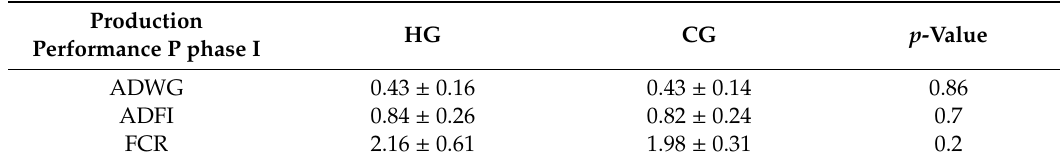
Table 4. E ff ect of gentle handling on production performance of pigs during phase I (mean ± standard deviation) ( p < 0.05). ADWG: average daily weight gain; ADFI: average daily feed intake; FCR: feed conversion ratio.